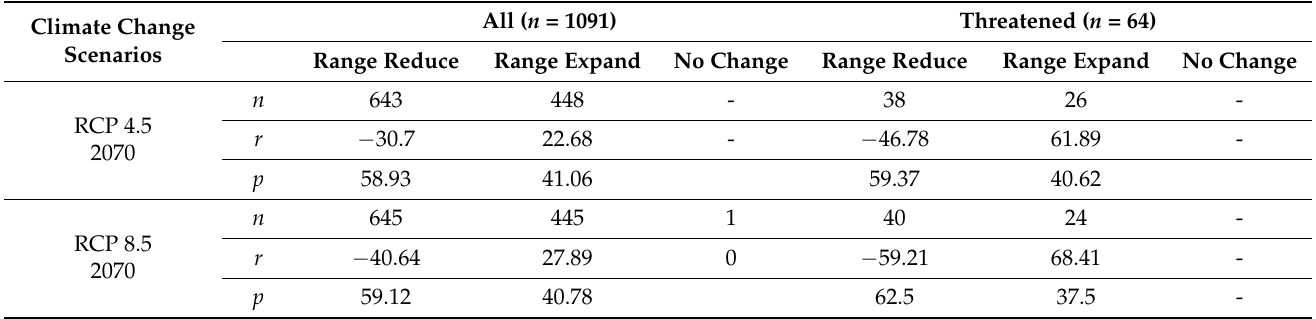
Table 2. Species range changes by the year 2070 for Indian terrestrial birds, along with